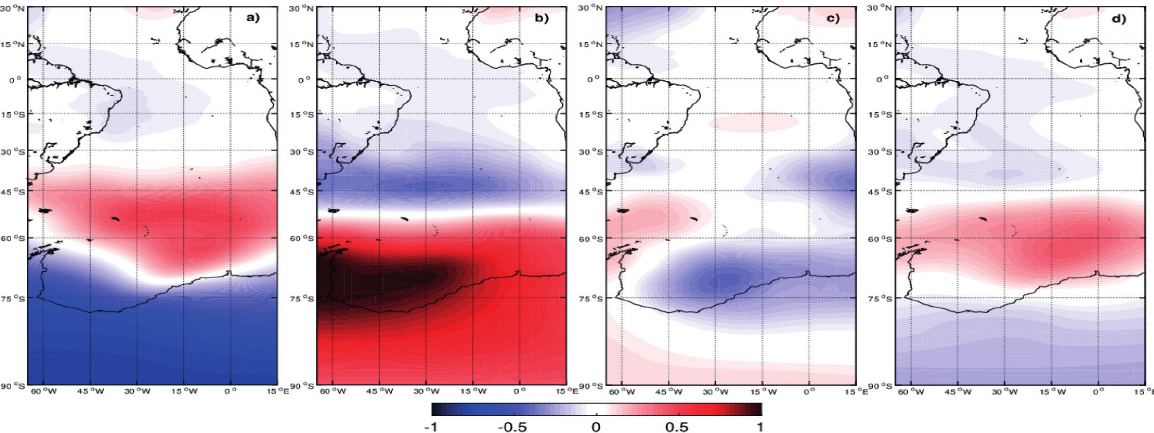
Figure 5. Differences between layermax-layerctl experiments for mean sea level pressure (hPa) during the